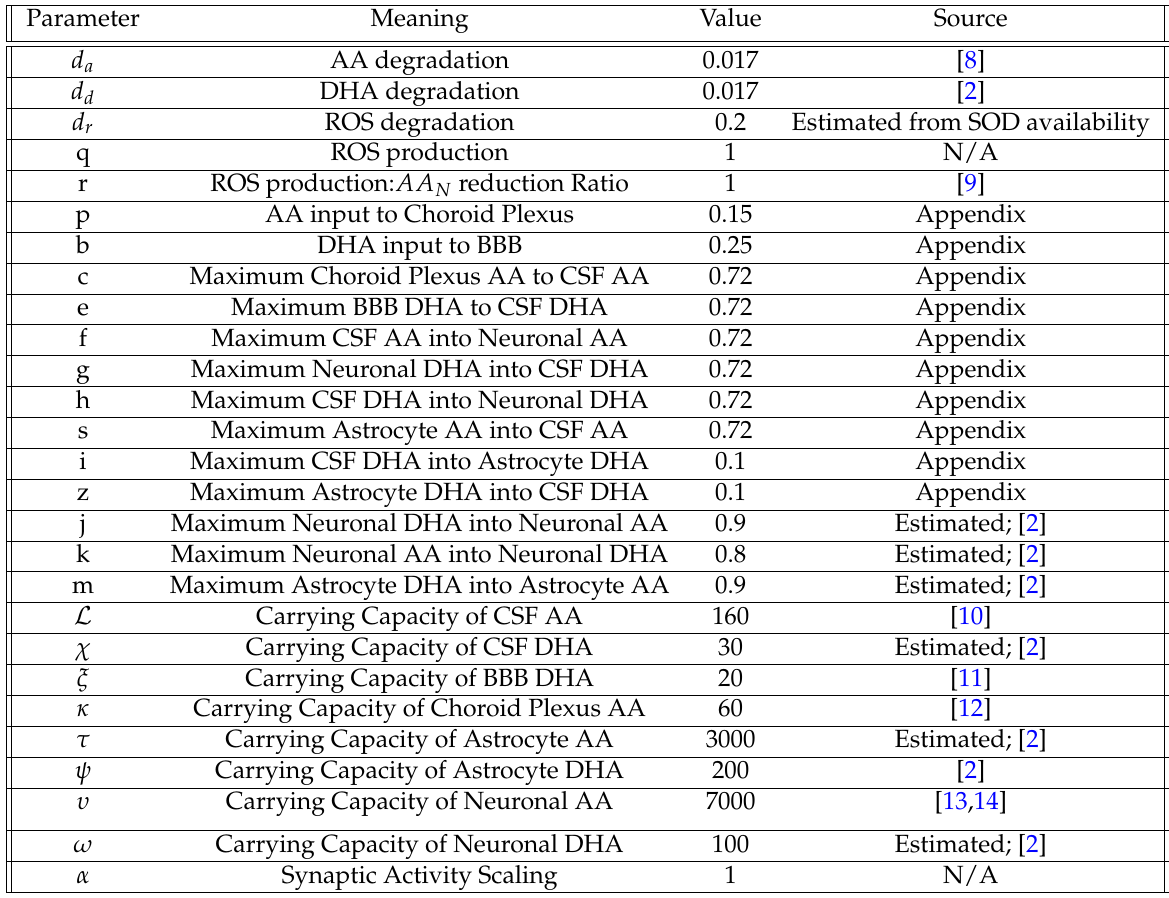
Table 1. Parameters Used in Creating Simulations